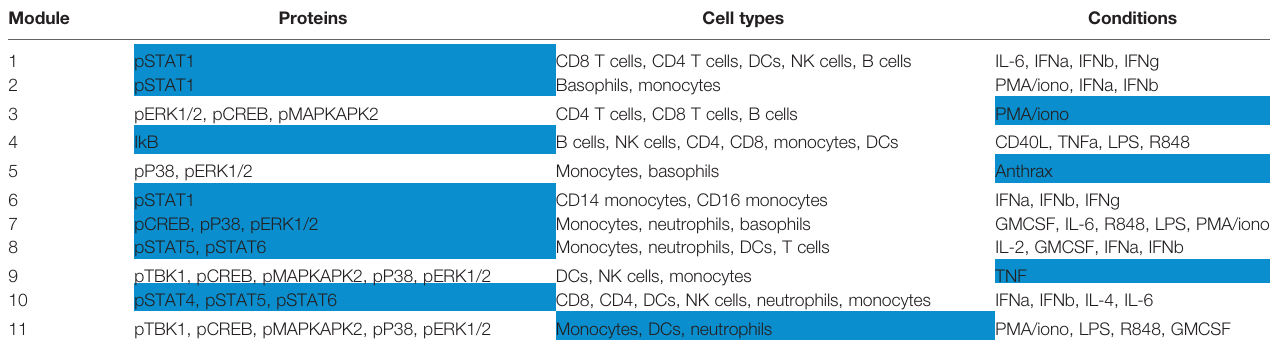
TABLE 1 | Attributes of features contained within each